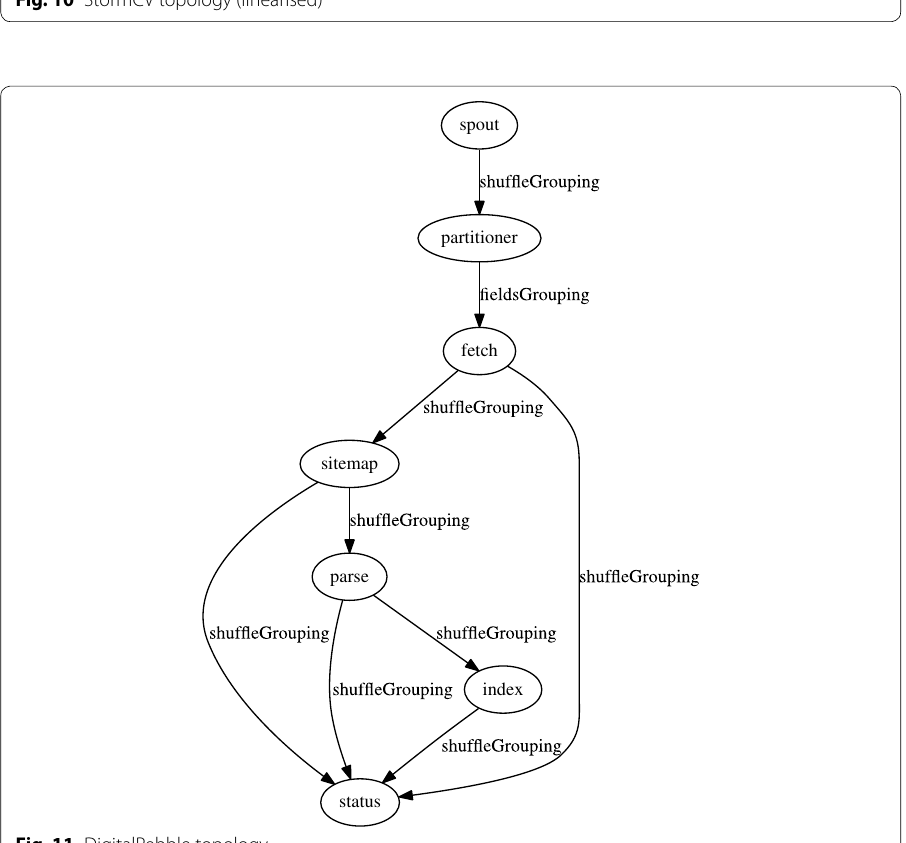
Fig. 10 StormCV topology (linearised)